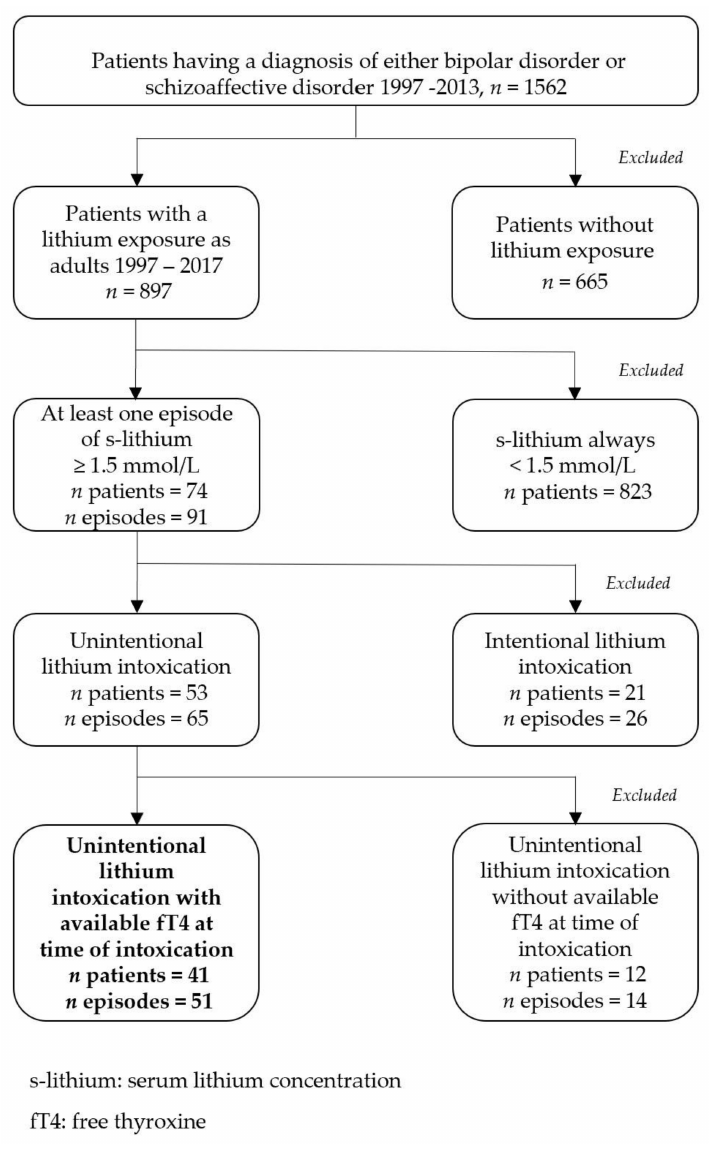
Figure 1. Selection of study sample. Table 1. Frequency of adverse drug reactions according to Council for International Organizations in Medical Sciences